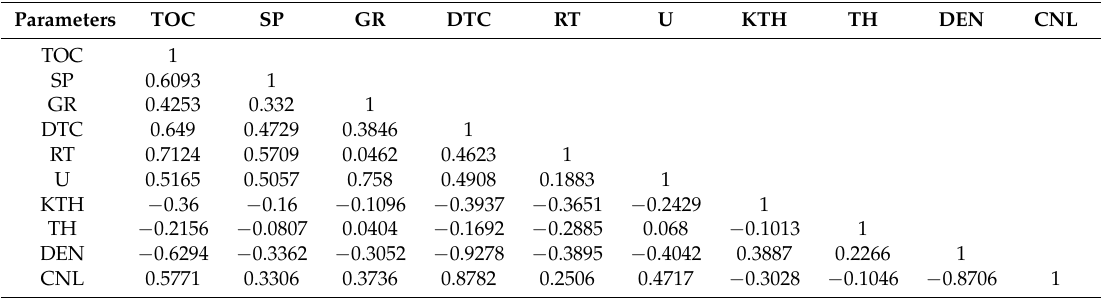
Table 2. Correlation matrix of Well E1.